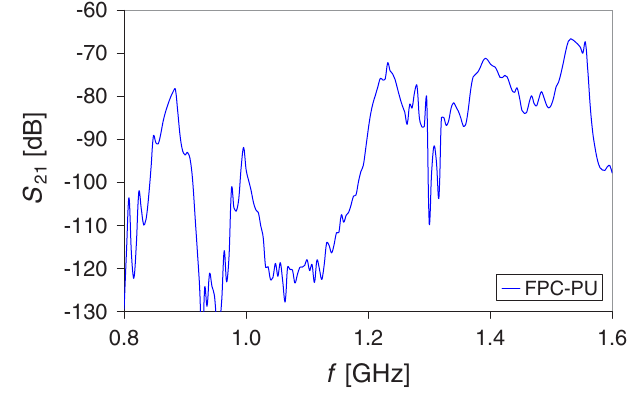
FIG. 9. (Color) S 21 signal from FPC to PU in the ERL